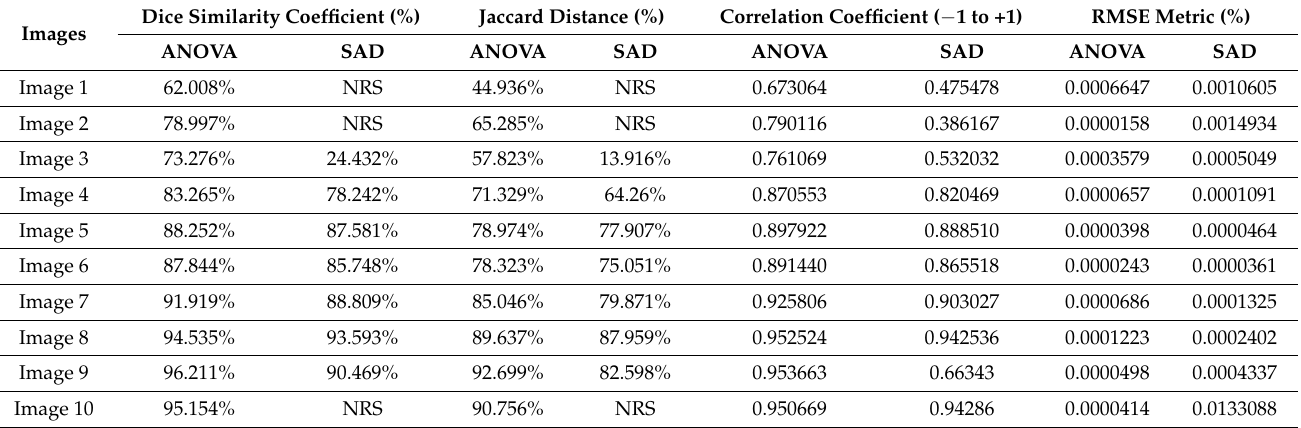
Table 4. The results of our segmentation method on the KICA dataset, using the Dice similarity coefficient, Jaccard distance, correlation coefficient, and RMSE metric with two fitness functions: ANOVA and NRS signifies « non ‐ relevant segmentation ».